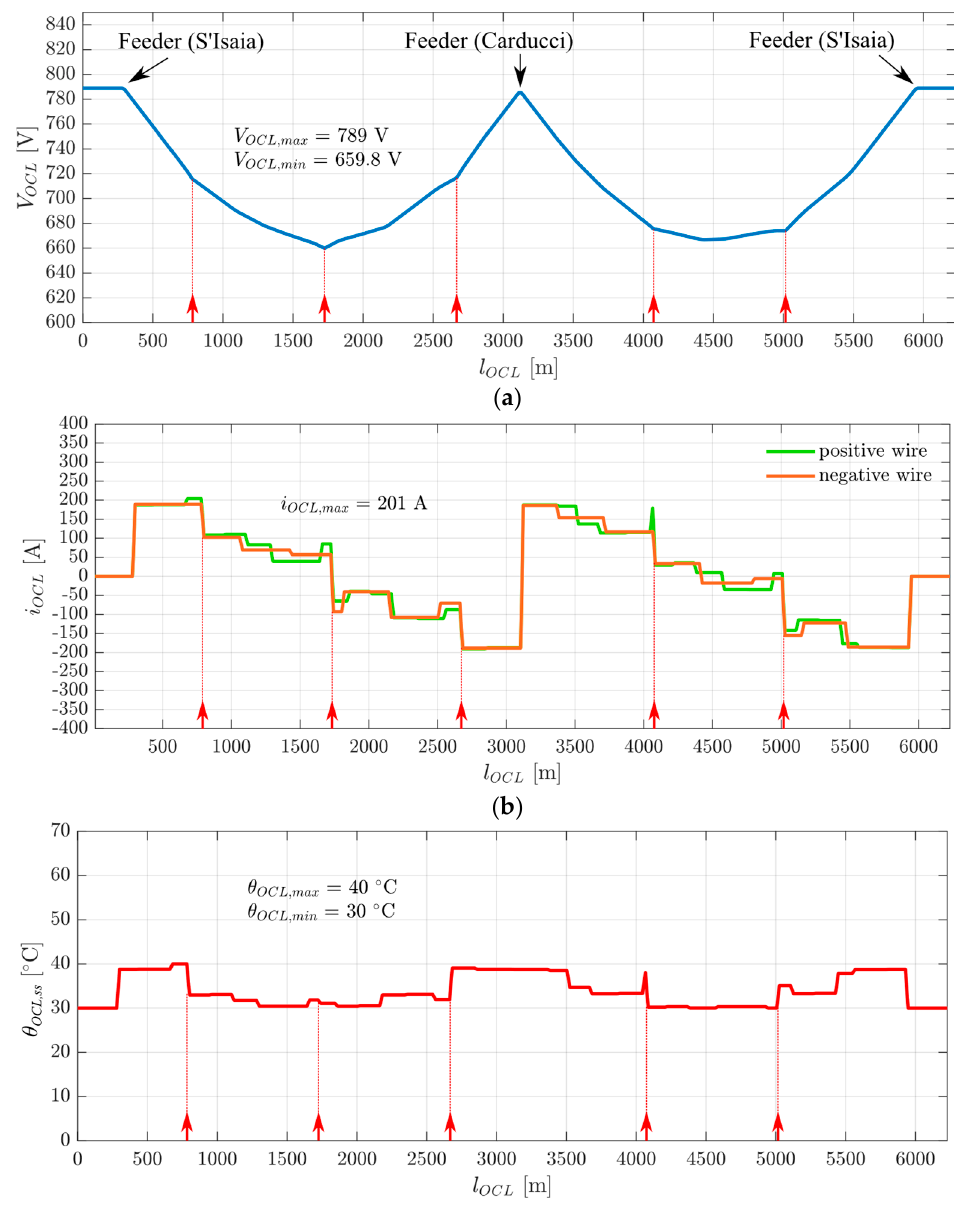
Figure 9. Distributions of OCL voltage ( a ), pole currents ( b ), and steady state temperature ( c ) along FS 1. Trolleybus positions are marked by red arrows.